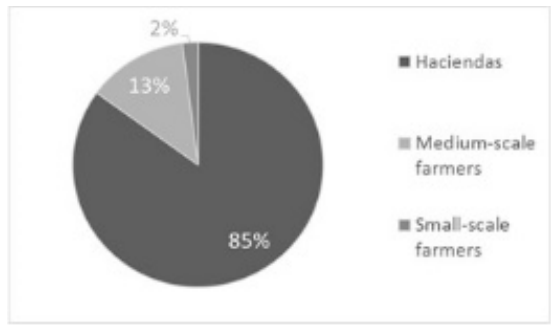
Figure 5. Types of properties affected by the alternative Baba project design [75].